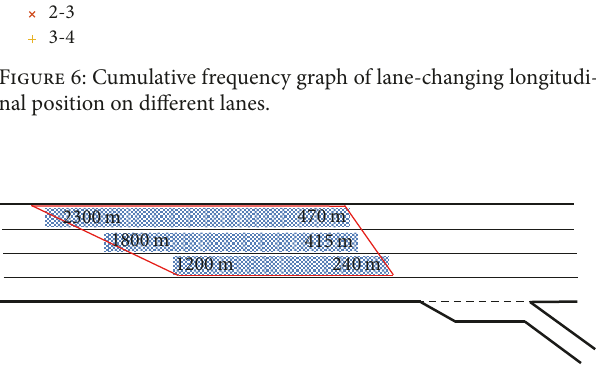
Figure 7: Range based on the 85 percentiles of lane-changing actions in each